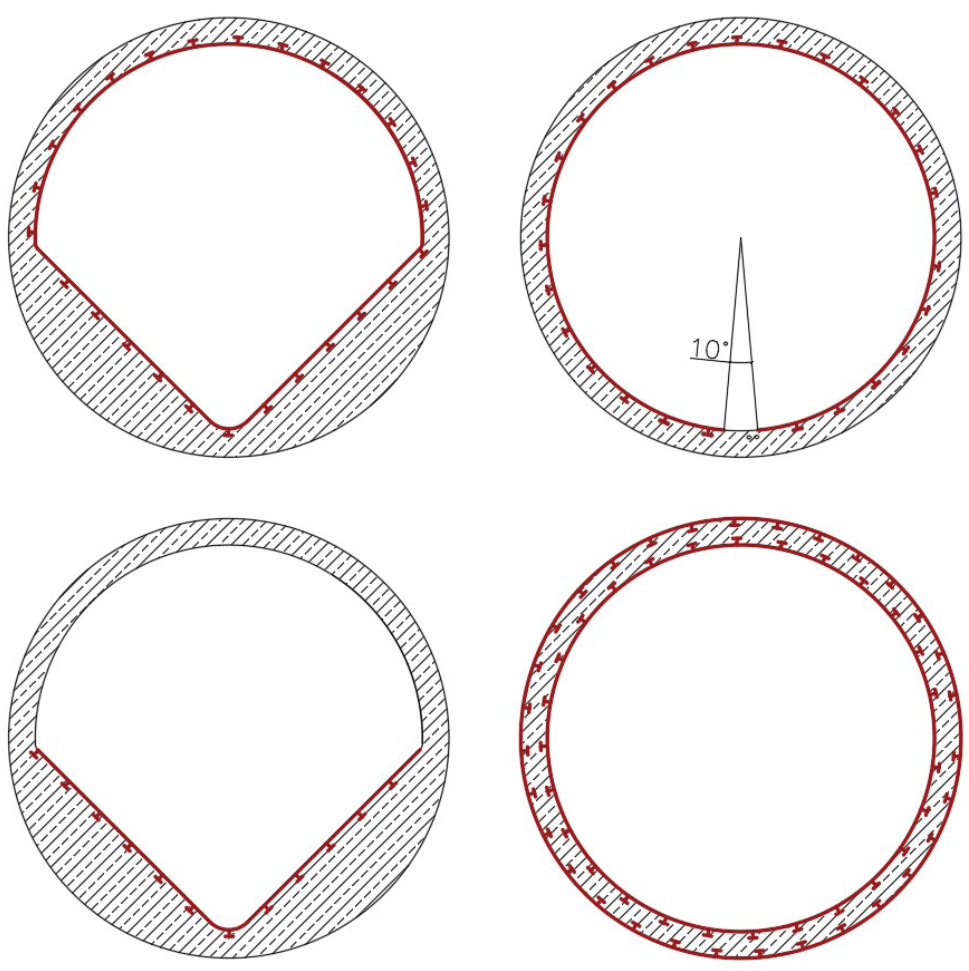
Figure 6: Different installation details of HDPE liners.